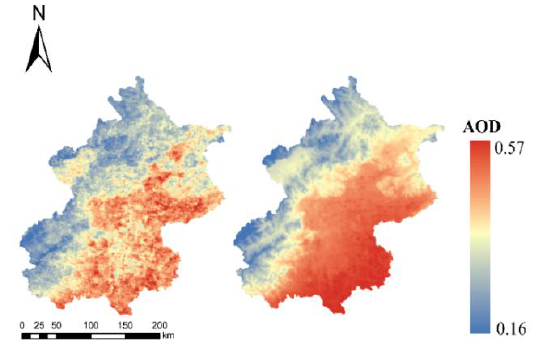
Figure 2. Average AOD in autumn and winter of Beijing (The left one is the cloud-removal SARA AOD and the right one is the gap-filled SARA AOD).